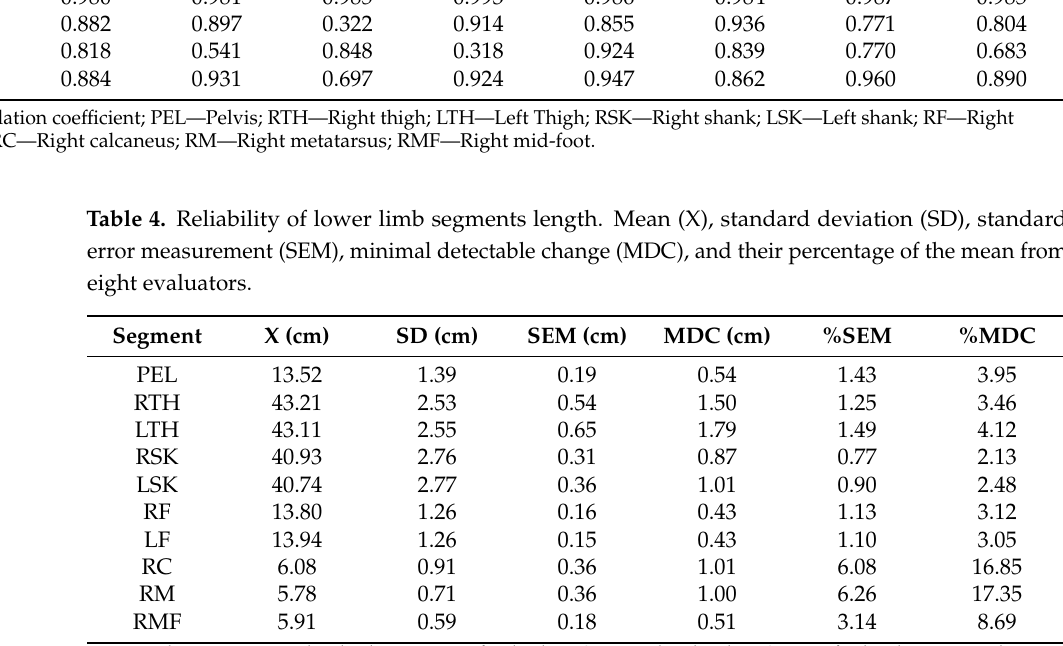
PEL—Pelvis; RTH—Right thigh; LTH—Left Thigh; RSK—Right shank; LSK—Left shank; RF—Right Foot; LF—Left foot; RC—Right calcaneus; RM—Right metatarsus; RMF—Right mid-foot. Lower limb segment length objectivity was greater than 0.8 for all evaluators for all segments. Table 5 presents the objectivity of lower limb segment length in individ- ual rounds. The lowest objectivity score of the lower limb segment length was in the right metatarsus segment, both in single standing calibration trials and for all records (0.694–0.860). The %SEM was less than 4% and the %MDC was less than 9% (Table